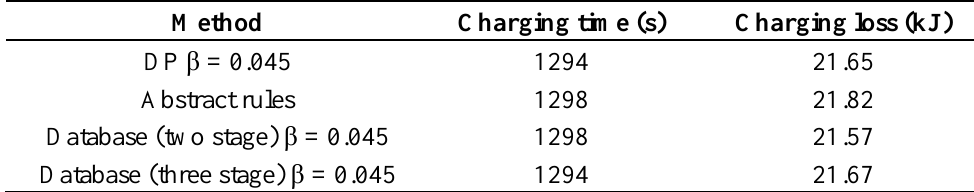
Table 3 . The simulation results comparison of different